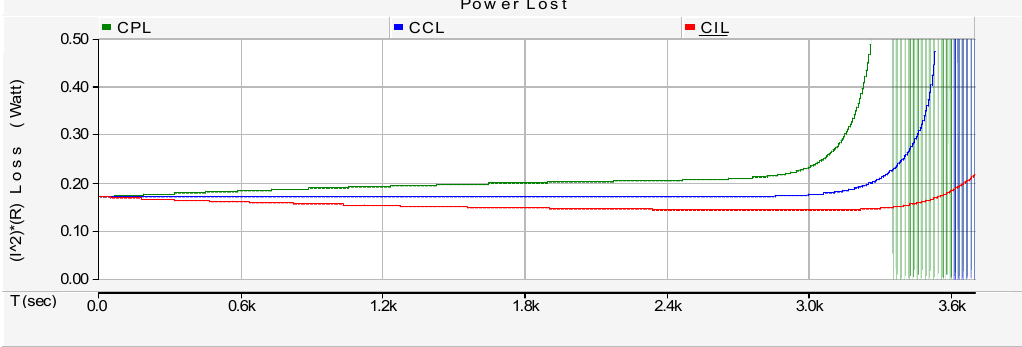
Figure 15. Change in internal resistance with the decrease in SOC (left to right). Figure 16. Instantaneous output ‐ power at the battery terminal. Figure 17. Power ‐ lost expressed as percent of power ‐ output.